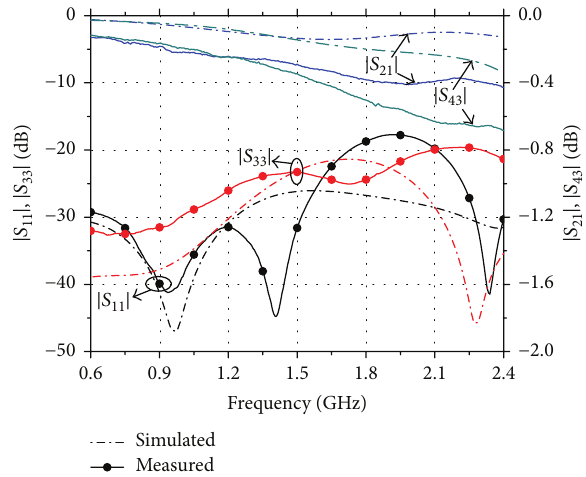
Figure 9: Simulated and measured 𝑆 -parameters of the 90 ∘ Schiff- man phase shifter configured with the PCMLFGPC.